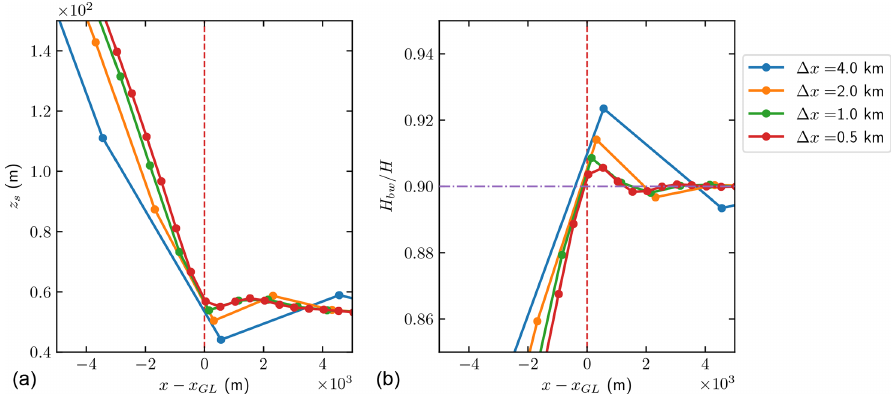
Figure 7. Details of the solutions for the advance experiment with (cid:49)x = 0 . 5 , 1 , 2 , 4km after 10000 years. The solid dots represent the nodes of the elements, and the vertical, dashed red lines indicate the GL position. (a) The oscillations in z s at the ice surface near GL. (b) The flotation criterion is evaluated by H bw /H . The ratio ρ/ρ w is drawn in a horizontal, dash-dotted purple line.